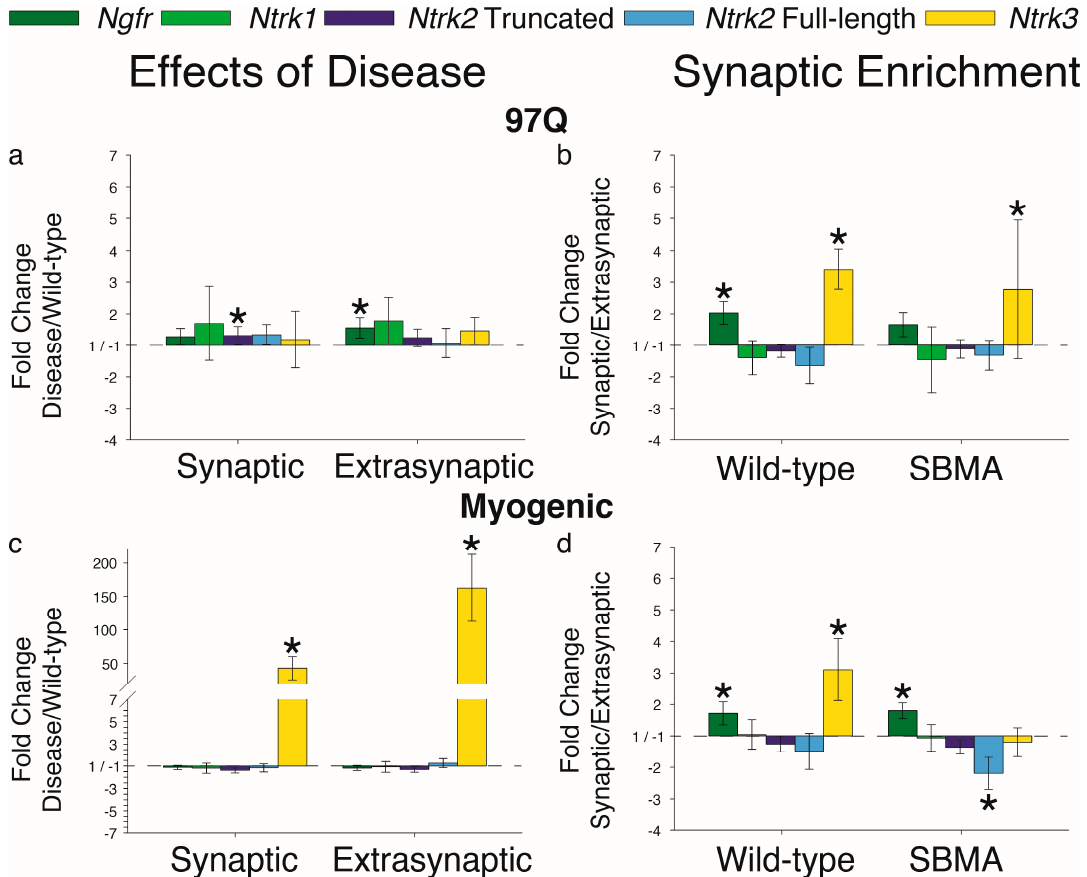
Figure 3. Disease has regionally specific effects on neurotrophin receptor expression. ( a , c ) Ngfr , truncated Ntrk2, and Ntrk3 showed effects of disease, although the effects depended on the specific model. Disease upregulated truncated Ntrk2 only in the synaptic region of muscle from 97Q but not myogenic mice. Disease robustly upregulated Ntrk3 in both regions of muscle from myogenic but not 97Q mice. ( b , d ) In wild-type control muscle, Ngfr and Ntrk3 were preferentially expressed in the synaptic region. Disease eliminated the synaptic enrichment of Ngfr in the 97Q model and of Ntrk3 in the myogenic model. In sum, expression of neurotrophin receptors in muscle is also susceptible to the toxic effects of a disease-causing androgen receptor, and likely contribute to the pathophysiology of synaptic and muscle dysfunction in SBMA. Fold changes ± SEM are relative to wild-type ( a , c ) or extrasynaptic ( b , d ) samples; Statistical analysis was based on pair-wise fixed reallocation randomization test: * p < 0.05.